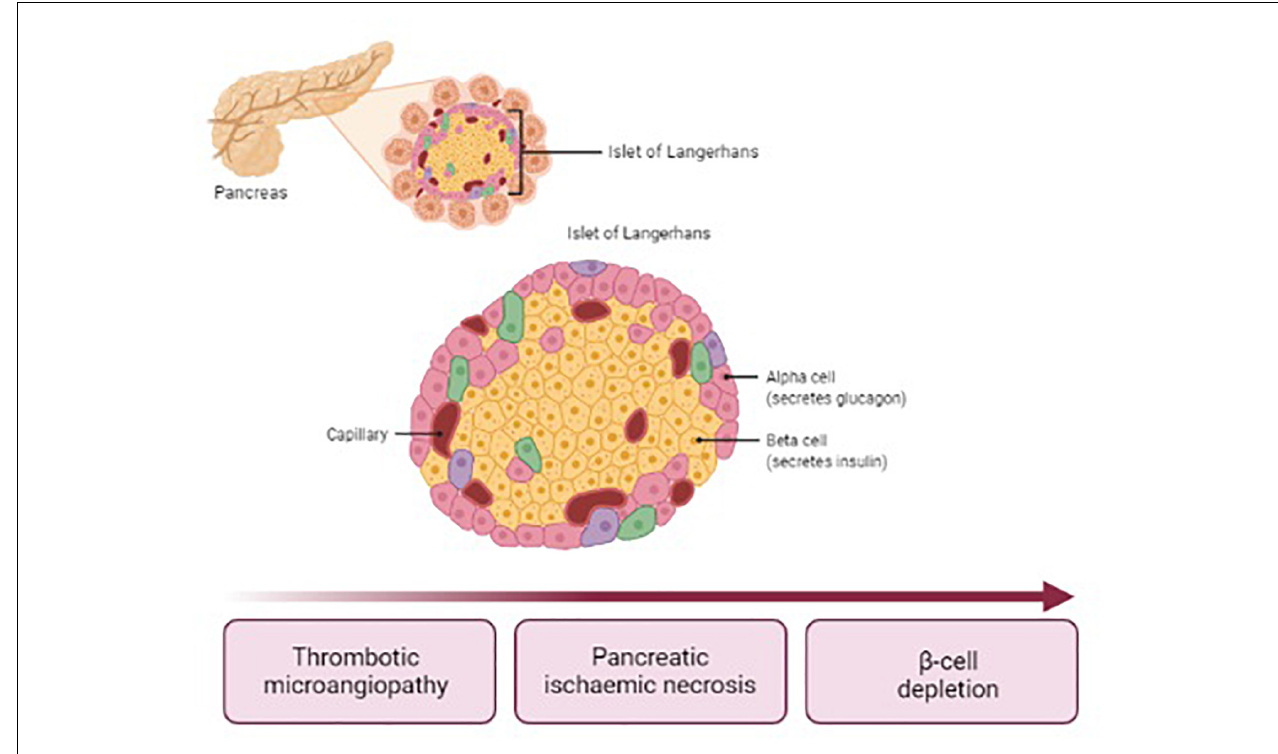
FIGURE 1 | Pathogenesis of post-HUS